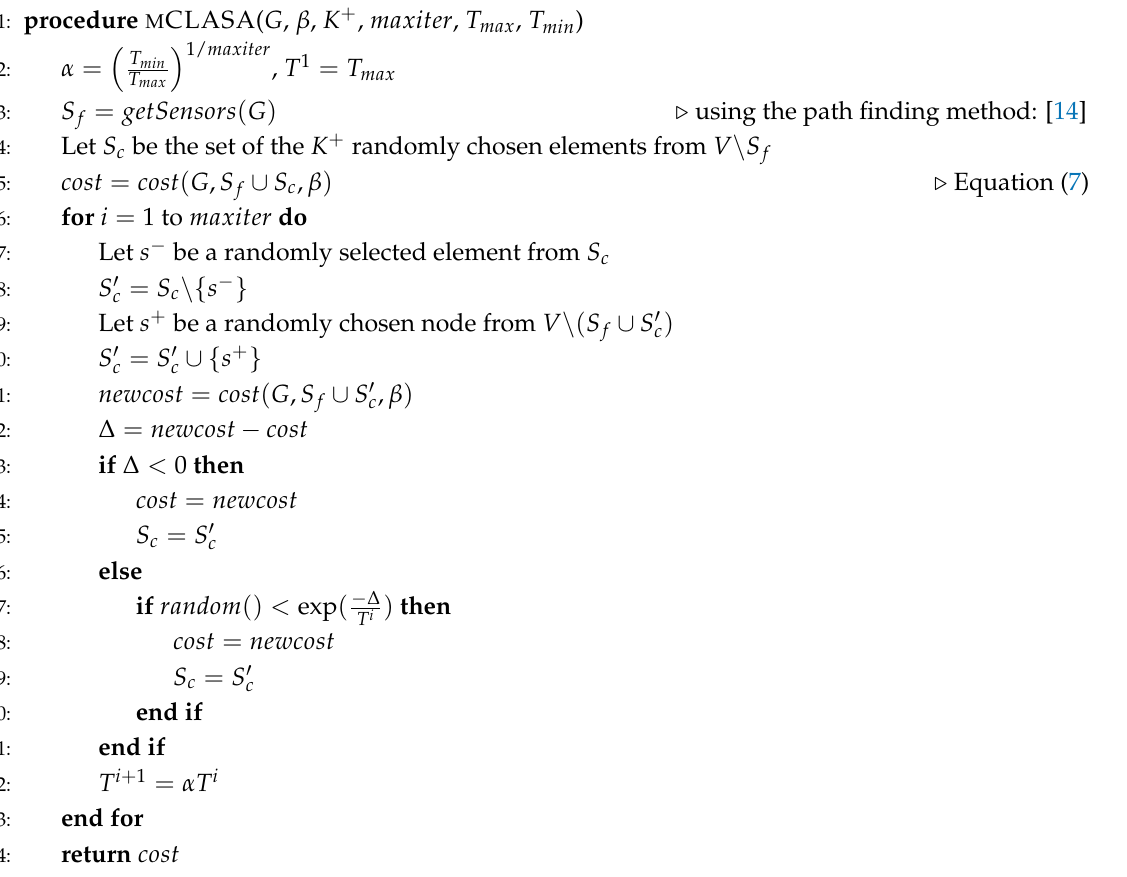
Algorithm 1 Pseudo code of the modified CLASA algorithm